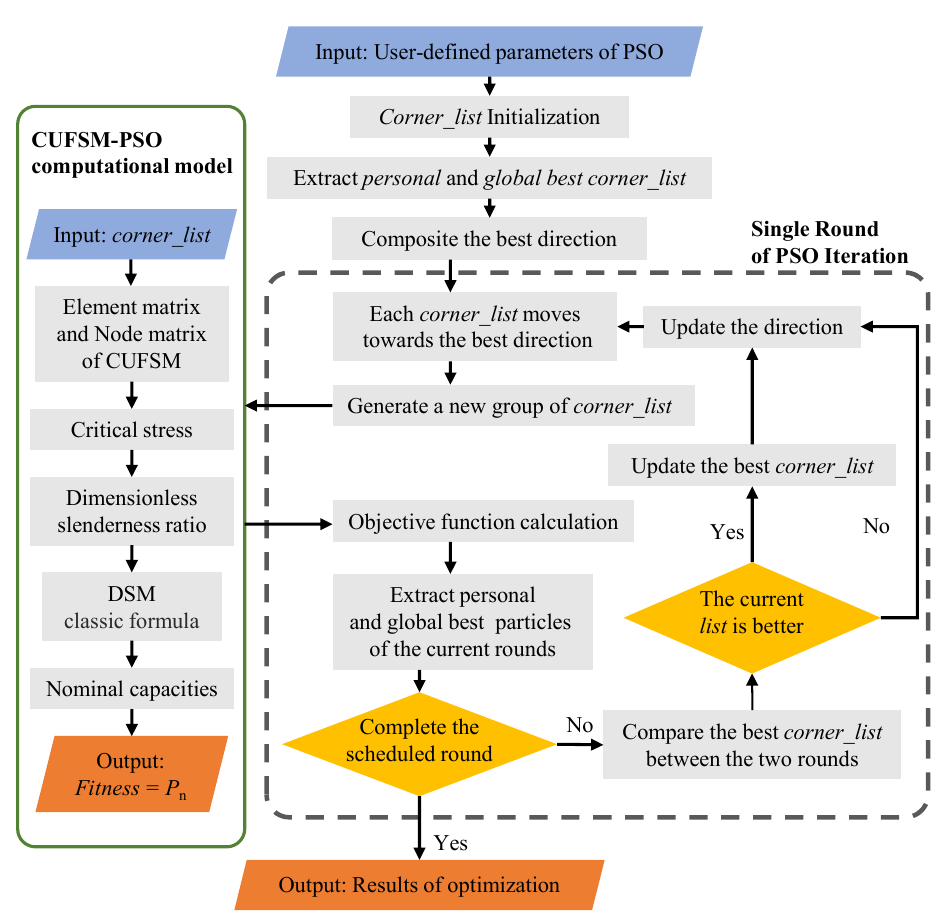
Figure 13. PSO algorithm flow chart. Table 1. PSO parameter definition.